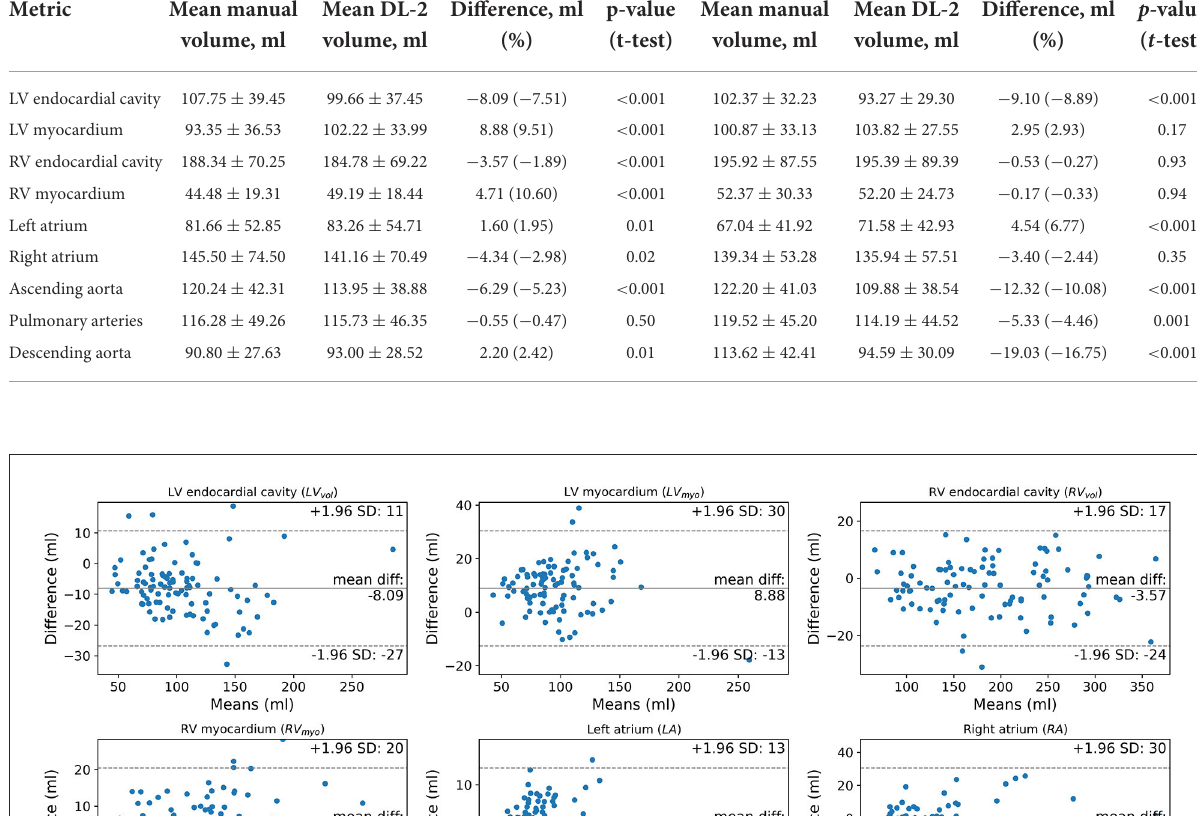
TABLE 5 Volumes of segmented cardiac structures for manual (observer 1) and DL model 2 segmentations in the internal and external test cohorts. Cohort Internal test cohort ( n = 100) External test cohort ( n = 20) Metric